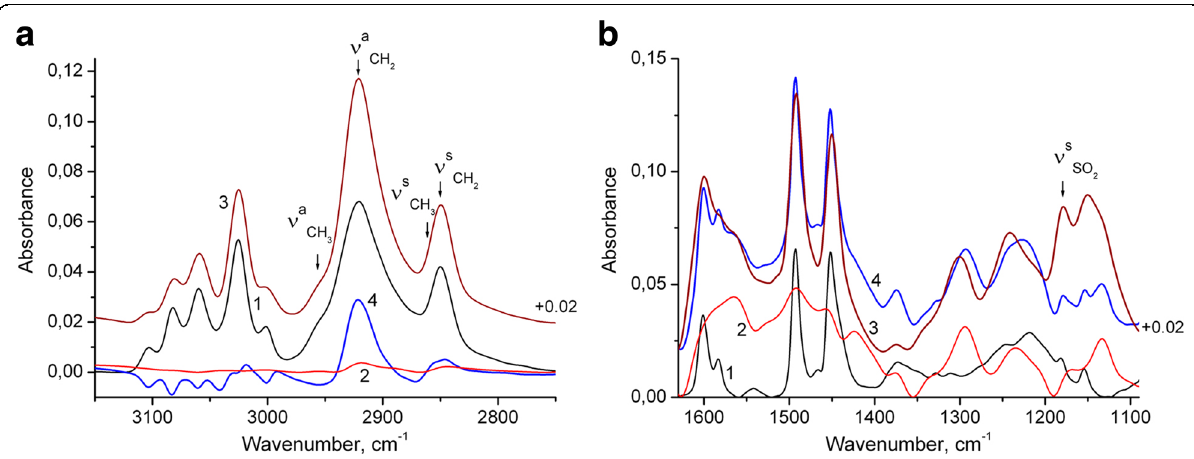
Fig. 3 FTIR spectra of PS nanoparticles (1), PANI-LSA (2), and NC15 (3): a spectrum 4 is the result of subtraction of the normalized PS spectrum from the NC15 one, b spectrum 4 is the sum of the PS spectrum (normalized to the band height of NC15 at 3025 cm − 1 ), and the PANI-LSA spectrum (normalized to the band height of NC15 at 1560 cm − 1